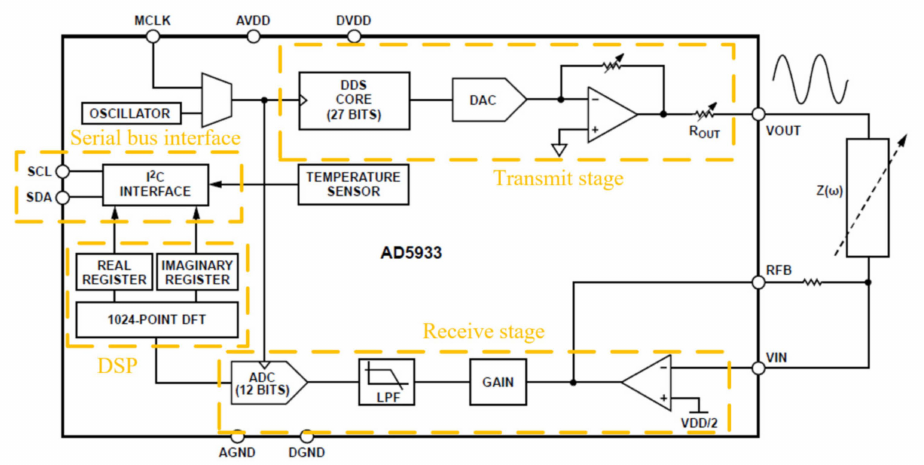
Figure 3. Block diagram of impedance measurement